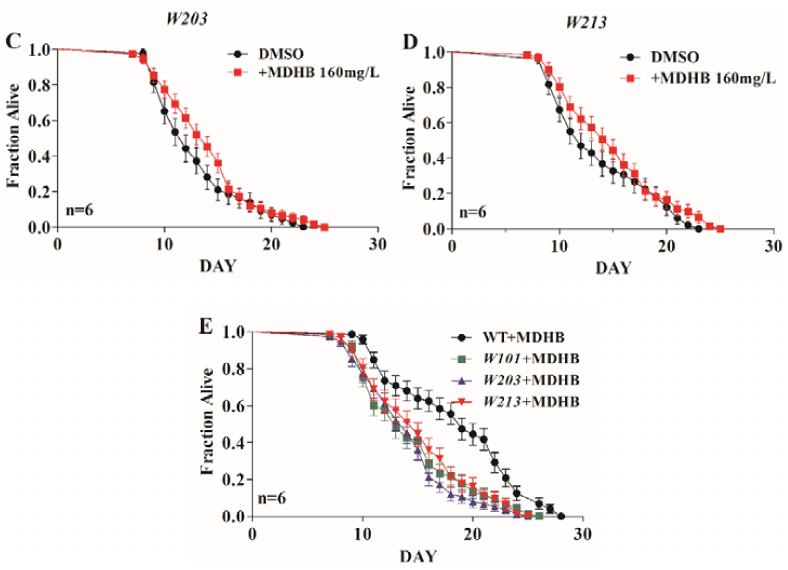
Figure 4. Effects of MDHB on the mean lifespan of W06A7.4 loss-of-function mutations ( W101 , W203 , and W213 strains). ( A ) Survival of the three W06A7.4 mutations ( W101 , W203 , and W213 ) compared to wild-type animals. The mutated worms ( W101 , W203 , and W213 ) had shorter lifespans than the wild-type N2 worms, p < 0.05. ( B – D ) Survival of mutated worms with W06A7.4 gene knocked out, with and without MDHB treatment. Treatment with MDHB notably enhanced mean lifespan of three W06A7.4 loss-of-function mutants, W101 (+11.6%, p < 0.05), W203 (+7.9%, p < 0.05), and W213 (+9%, p < 0.05). ( E ) Survival of three W06A7.4 loss-of-function mutations ( W101 , W203 , and W213 strains) and wild-type animals exposed to MDHB. Data are represented as mean ± S.E.M; statistical details are summarized in Table 1.